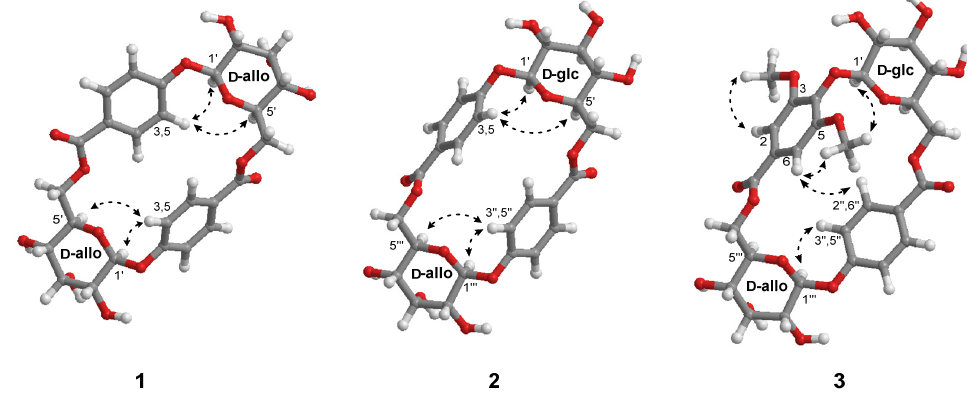
Figure 3. Key ROESY correlations for compounds 1 – 3 .